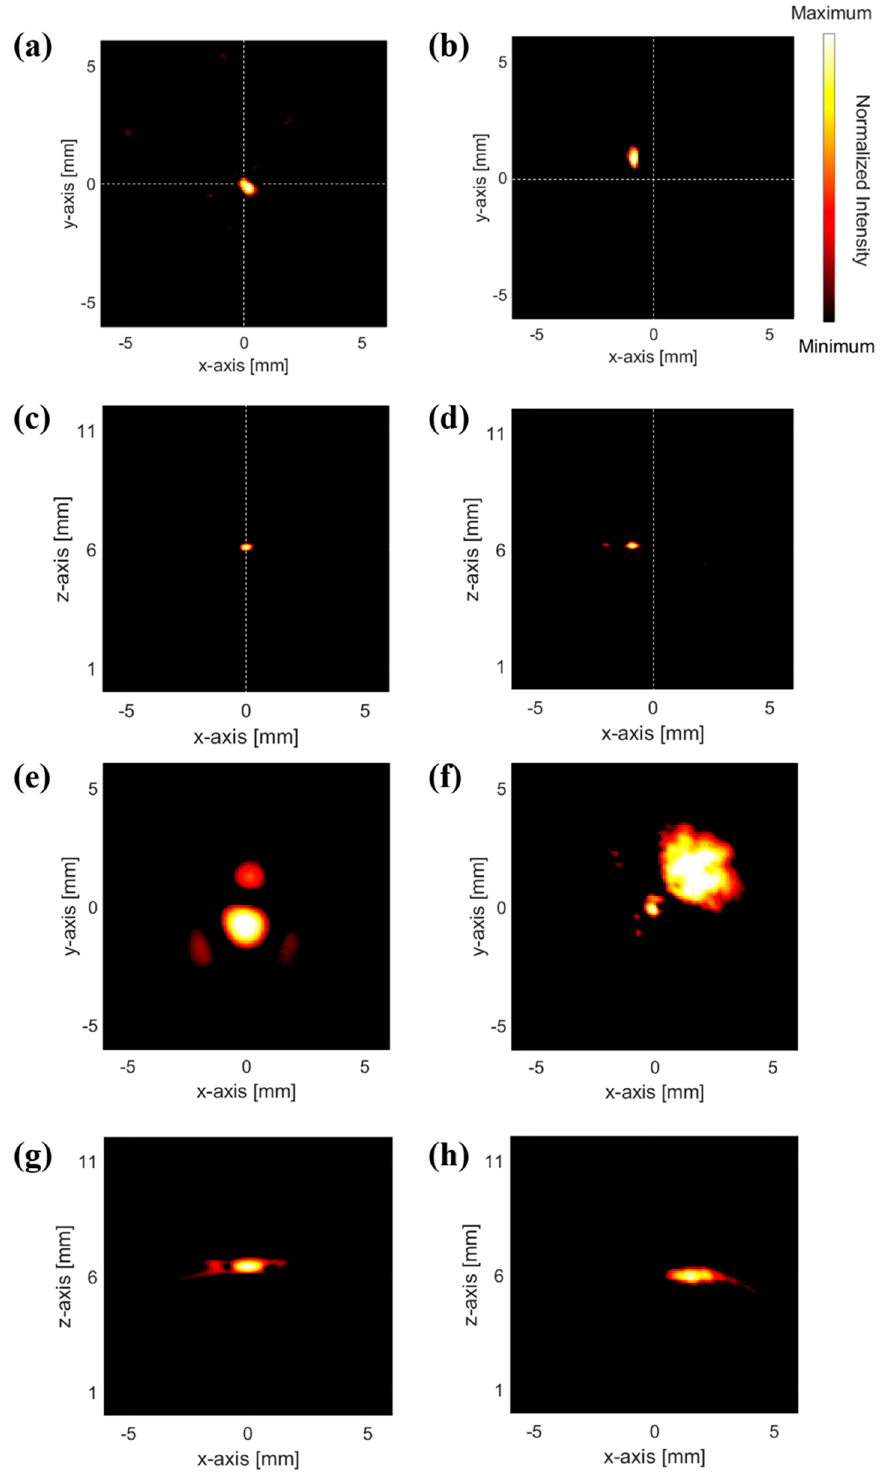
Figure 2. C-mode PA images of 0.3 mm pencil lead, ( a ) on-axis ( b ) off-axis. B-mode PA images of 0.3 mm pencil lead, ( c ) on-axis ( d ) off-axis. C-mode PA images of 2 mm red ink, ( e ) on-axis ( f ) off-axis. B-mode PA images of 2 mm red ink, ( g ) on-axis ( h ) off-axis.